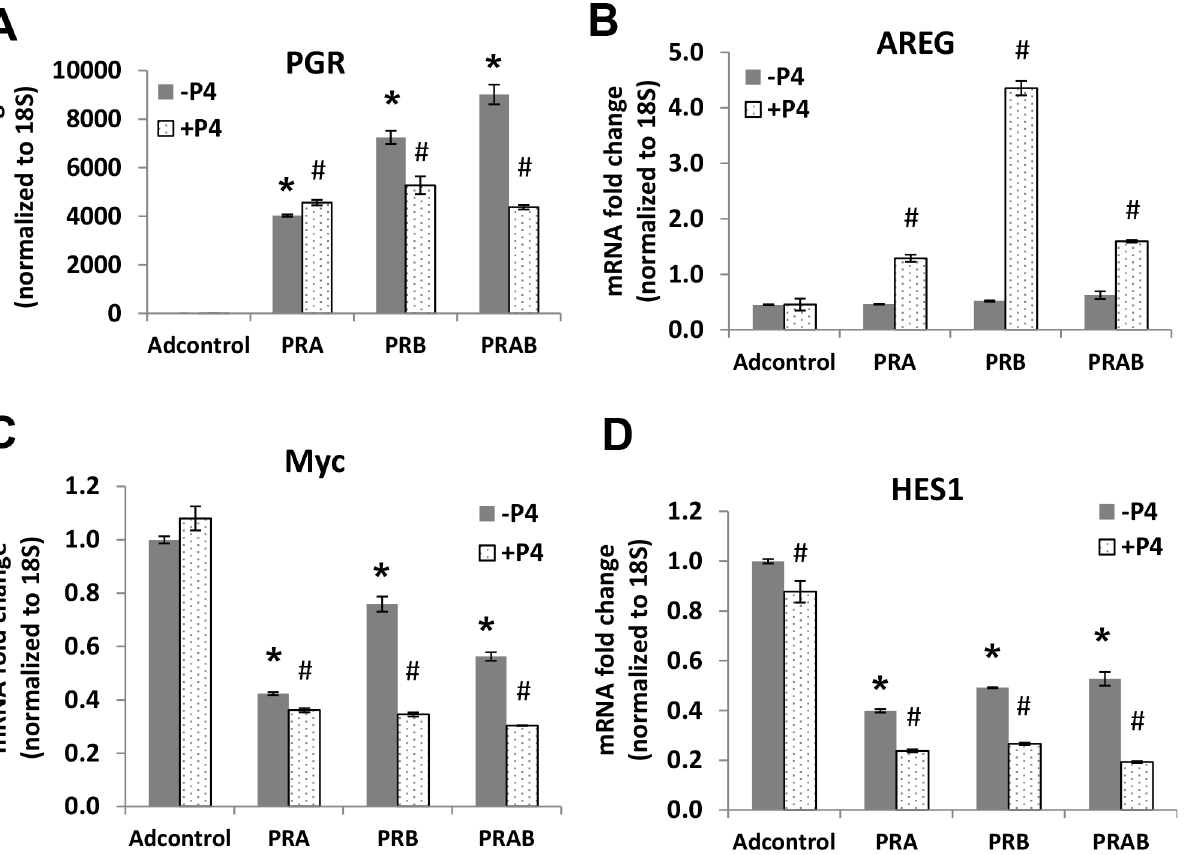
Fig 6. Overexpression of PR decreases Myc expression and activity. ECC1- ESR1 CRISPR KO clone 1 – 12 was transduced with control adenovirus (Adcontrol) or adenovirus containing PRA, PRB, or PRA+PRB for 24 hr, followed by 100 nM P4 for an additional 24 hr. mRNA levels were quantified by qRT-PCR, normalized to 18S, and data expressed as fold change relative to Adcontrol in the absence of P4. Results are representative of 3 independent experiments; * p < 0.05 vs. Adcontrol; # p < 0.05 vs. – P4 in the same group.